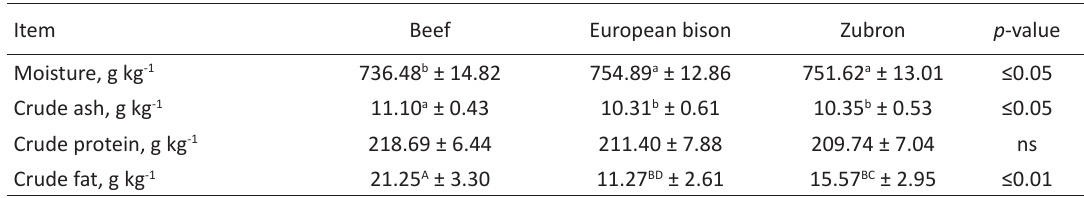
Table 2. Chemical composition of musculus semitendinosus muscle Item